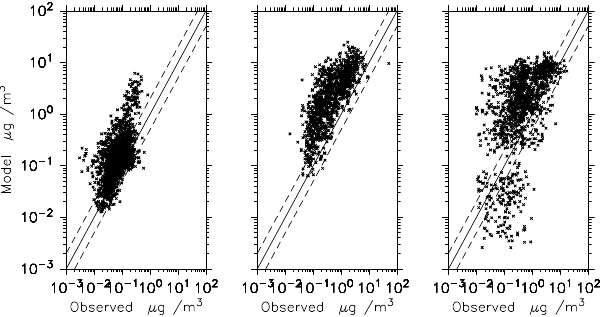
Fig. 12. Scatter plots of station observed and modelled monthly averaged concentrations (in µgm − 3 ) for the year 2005–2008 of Na + . Left: observations from CASTNET, middle: observations from EMEP, right: observations from